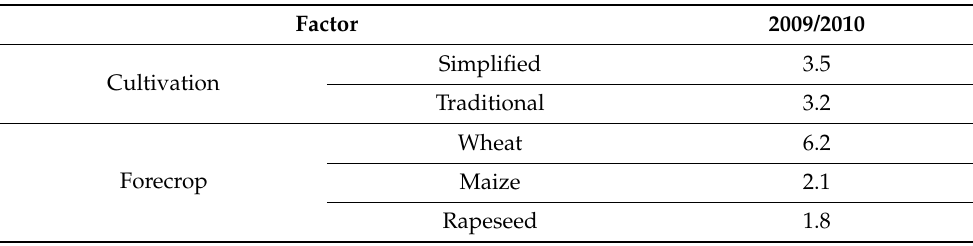
Table 4. Percentage of ear area infected by Septoria nodorum . Reprinted from reference